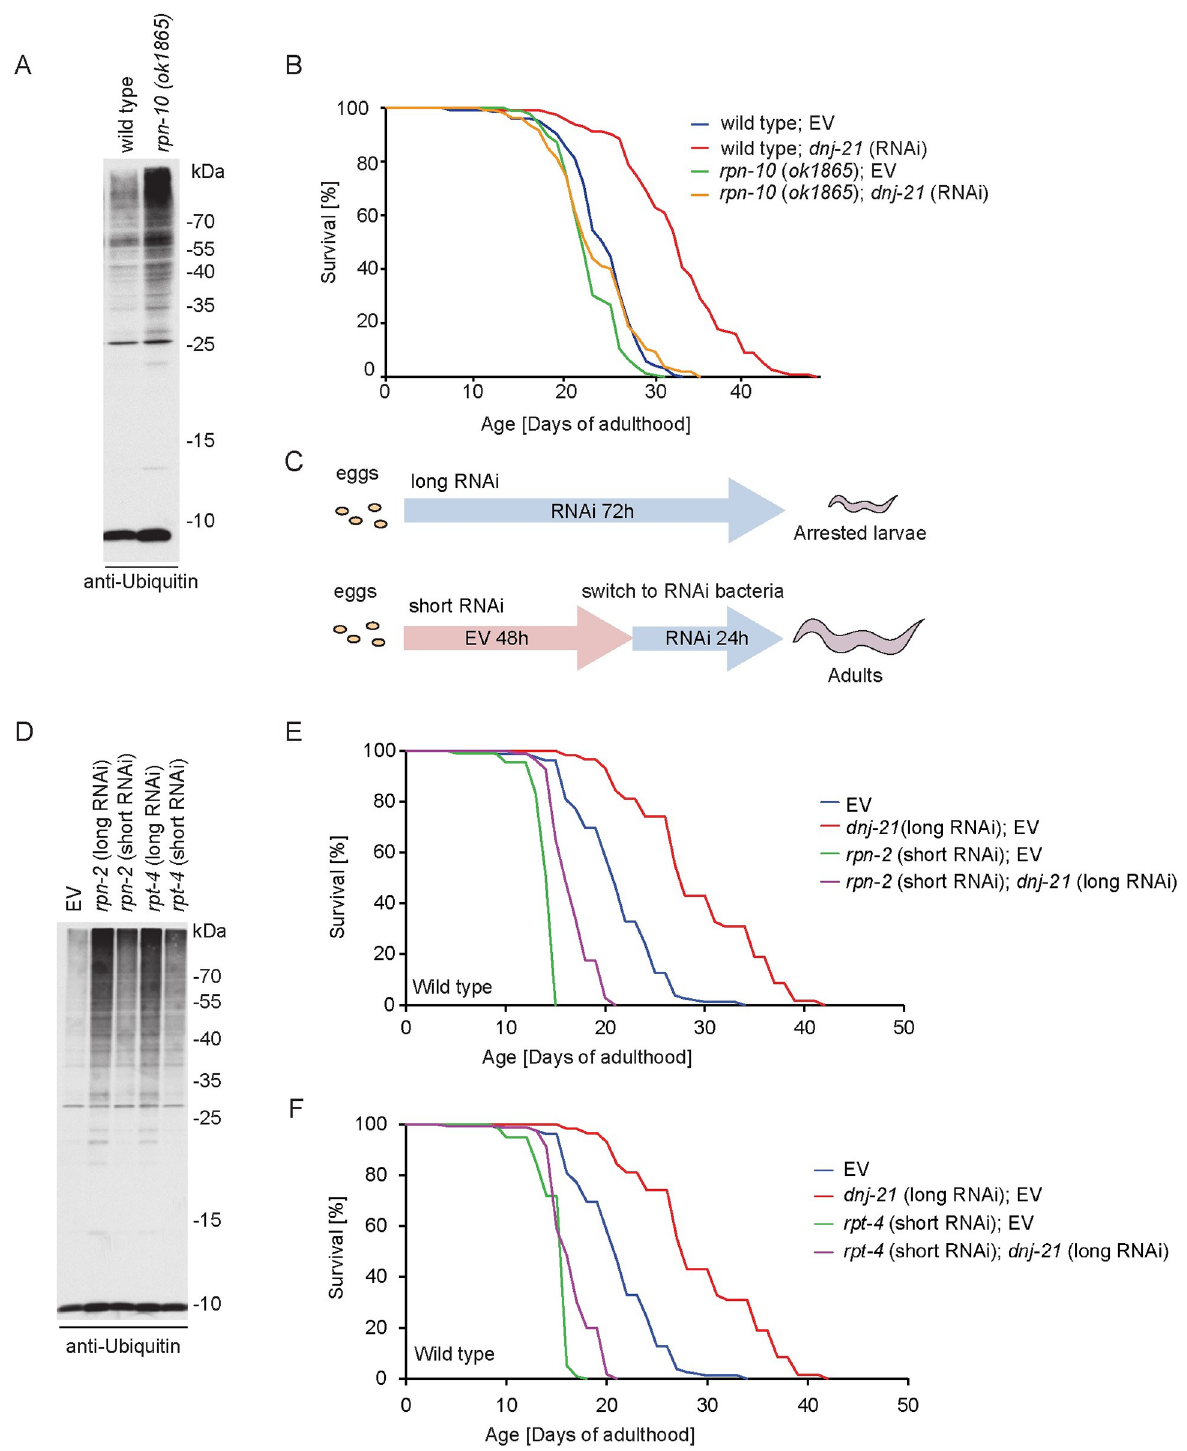
Fig 7. Life span prolongation depends on the proteasome. (A, D) Total worm lysates were separated by SDS-PAGE and analyzed by western blot using ubiquitin or specific antibody. Western blot analysis was repeated in 3 biological replicates. (B) Survival curve of wild-type worms and worms with the deletion of rpn-10 that were treated with RNAi as indicated. Life span values are presented in S2 Table. (C) RNAi treatment schema for the depletion of rpn-2 and rpt-4 . The depletion of either target throughout development resulted in strong larval arrest, and the worms did not reach adulthood. Embryos were placed on plates with EV RNAi for the first 48 h of development and then switched to plates with RNAi for certain genes.